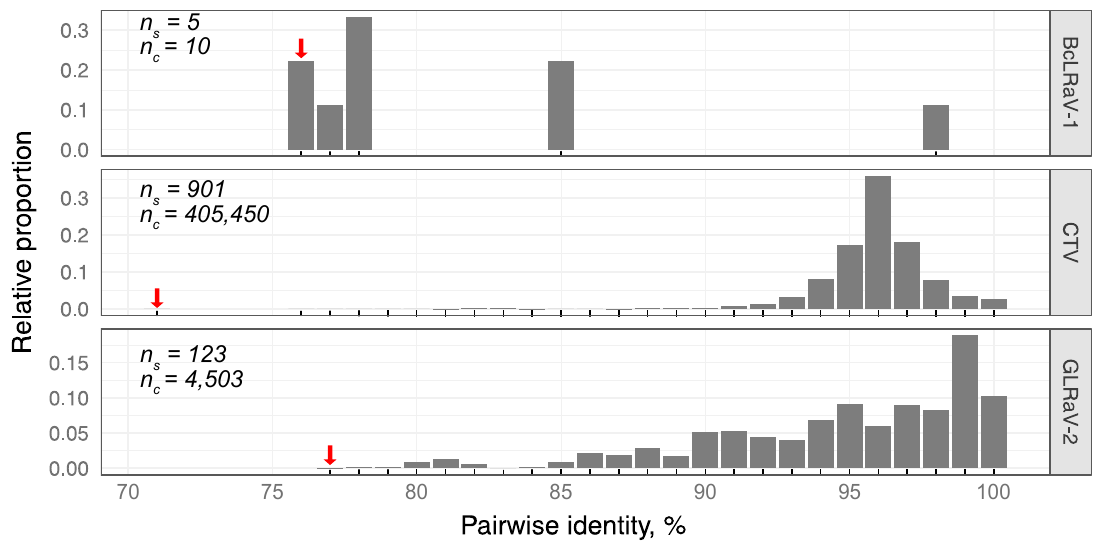
Figure 4. Distribution of the pairwise amino acid CP sequence homologies of BcLRaV-1, GLRaV-2, and CTV isolates. Complete protein sequences were obtained from GenBank (June 2018). The number of analyzed sequences (ns) and their pairwise combinations (nc) are shown. The lowest identity value is indicted by a red arrow. Additionally, the positions of the data points along the x axes are denoted by tick marks.